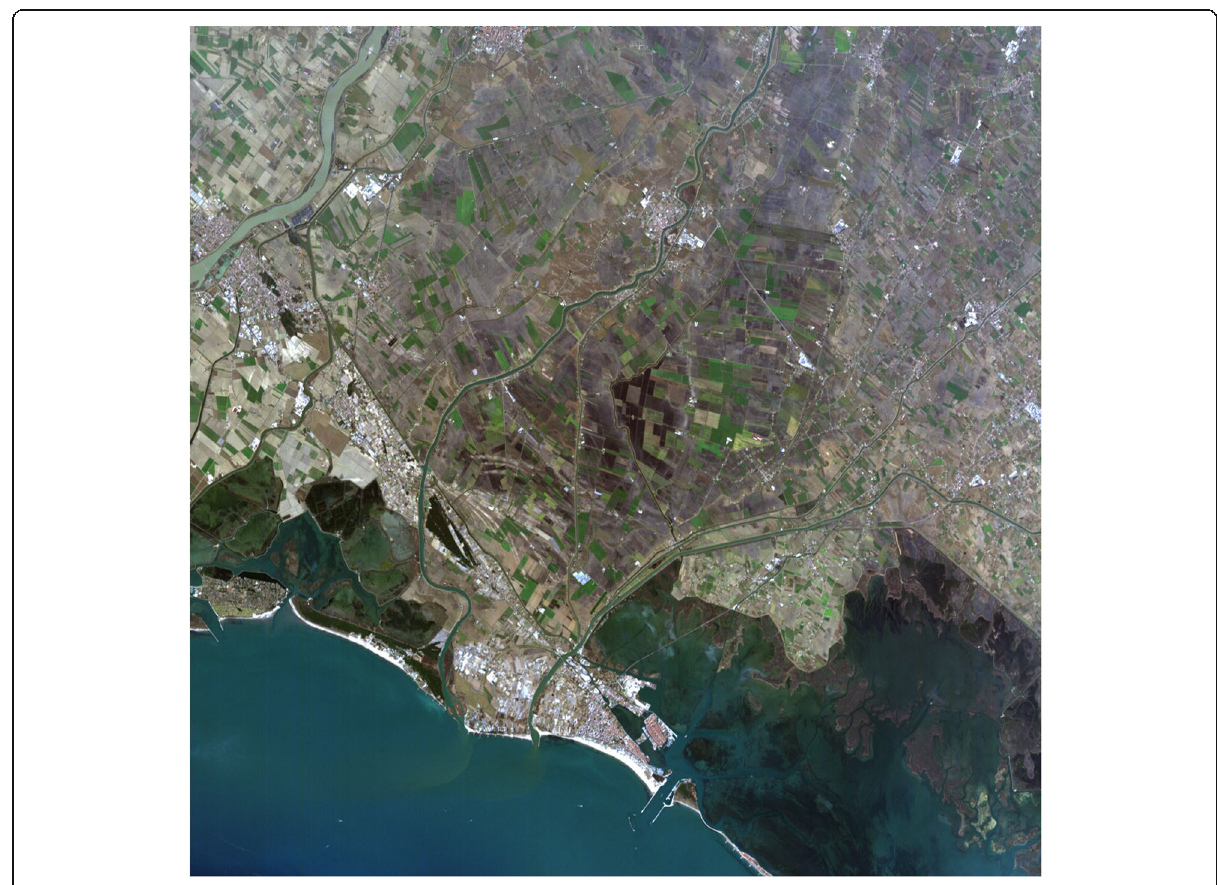
Fig. 19 This is a true color image of the coastal region near the small city of Sottomarina, Italy (white pixels), located on a peninsula protruding into the Lagoon of Venice. On land, the agricultural fields are easily seen, while many features in the lagoon and coastal waters are evident. Note that the Brenta River cuts through farmland, sending a plume into the lagoon. This image was acquired by DESIS on 8 February 2019. Image from DLR Earth Observation Center